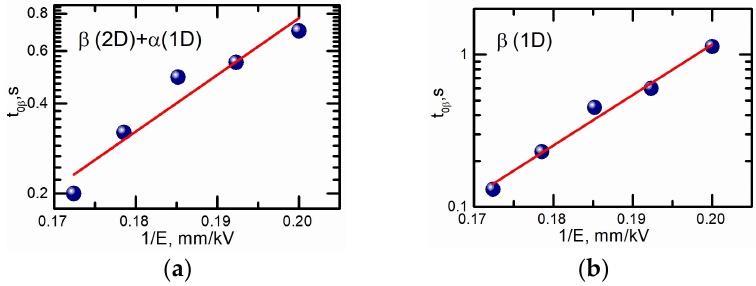
Figure 9. The field dependence of the characteristic times obtained by fitting of the switching current data: ( a ) β(2D) + α(1D) process and ( b ) β(1D) process. data: ( a ) β (2D) + α (1D) process and ( b ) β (1D) process.